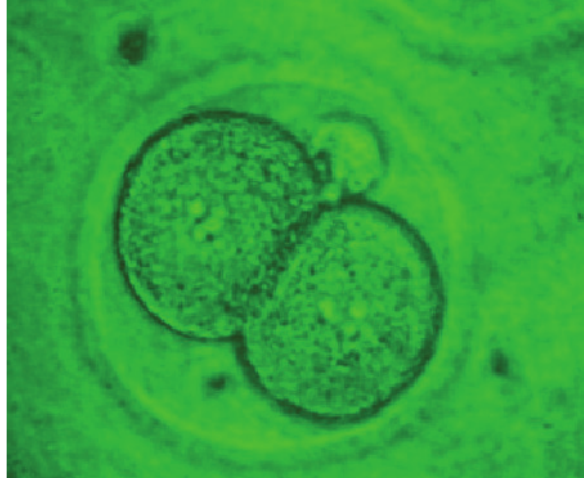
) após 48 h de incubação. 4